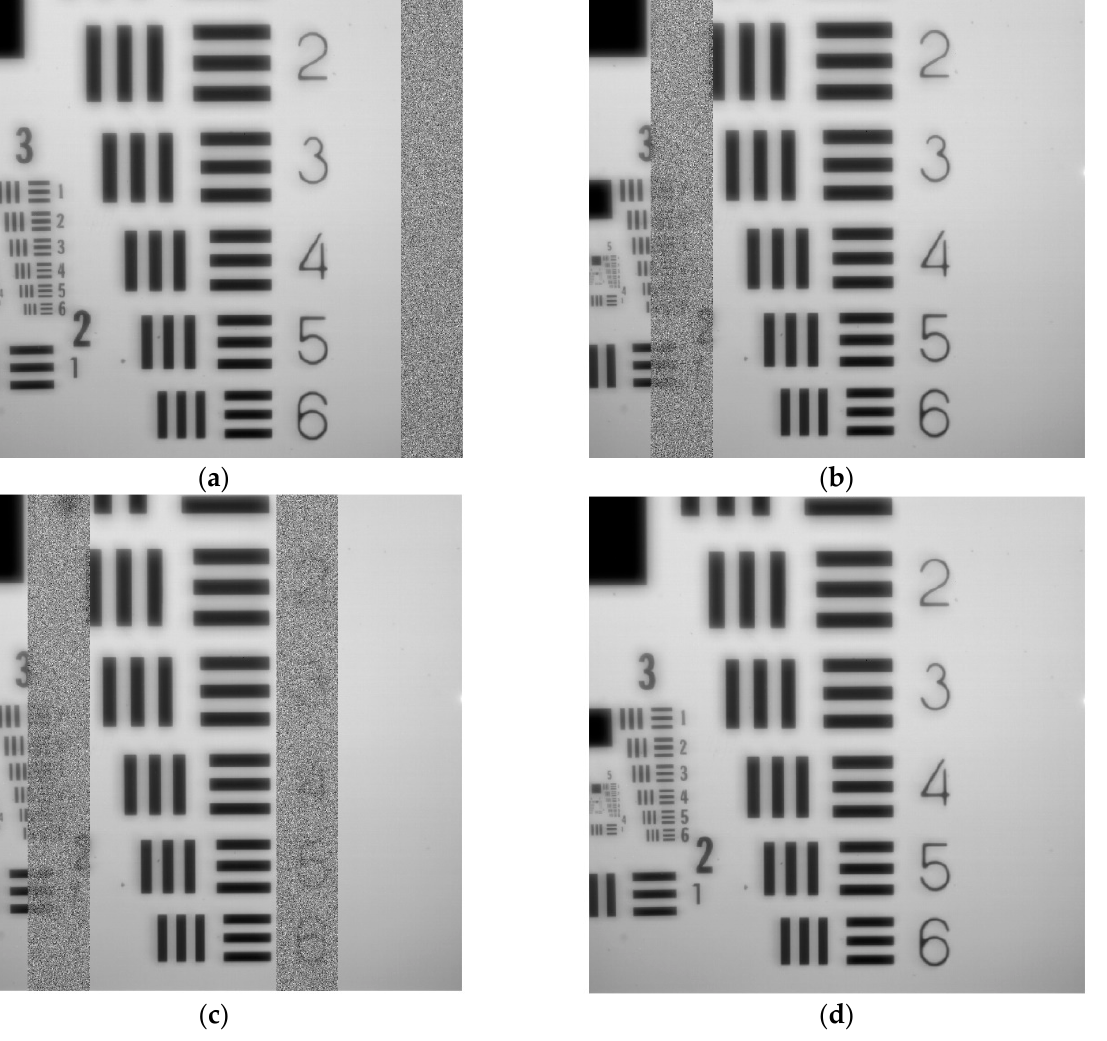
Figure 16. A 12-bit 2048 × 2048 image from GSENSE400 using the USAF pattern: ( a ) calibration error in channel seven; ( b ) calibration error in channel one; ( c ) calibration error in channels one and five; ( d ) successful calibration.